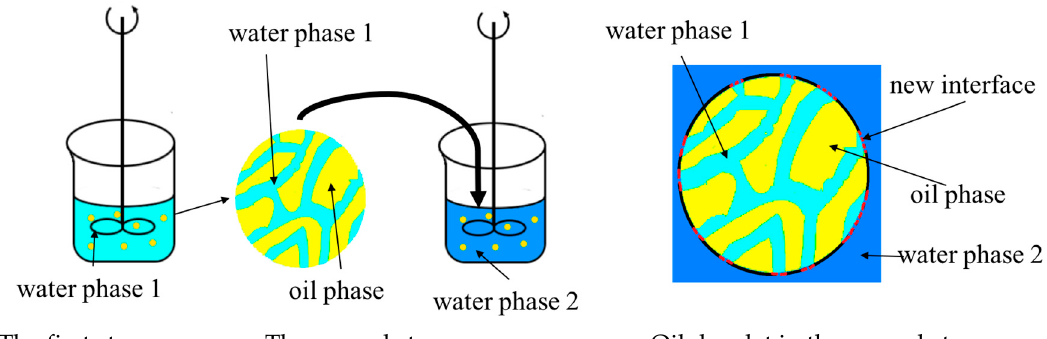
Figure 1. Two-step method to prepare the aqueous two-phase system (ATPS).